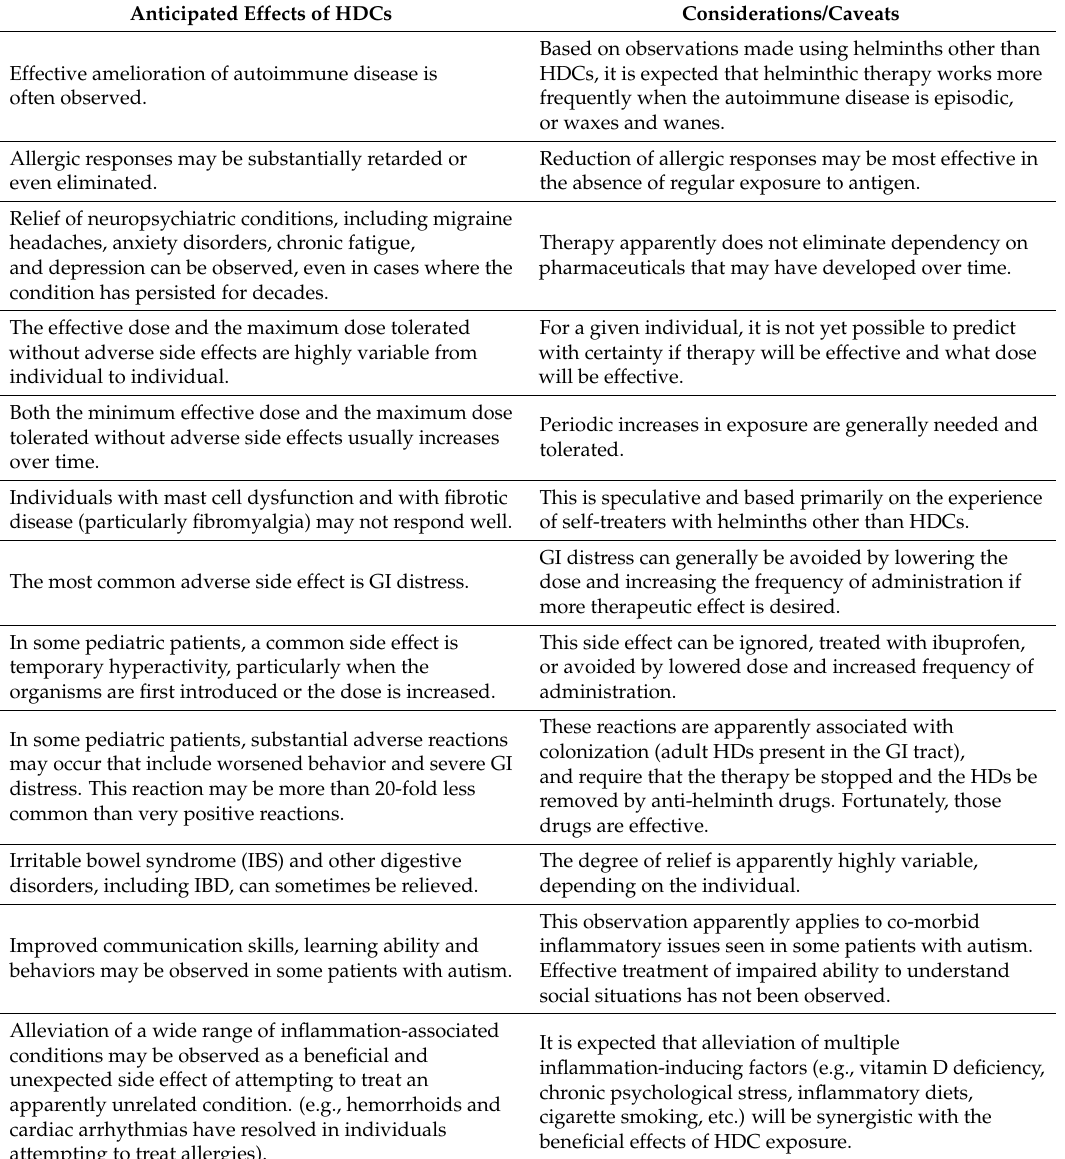
Table 1. General effects of HDC exposure based on socio-medical